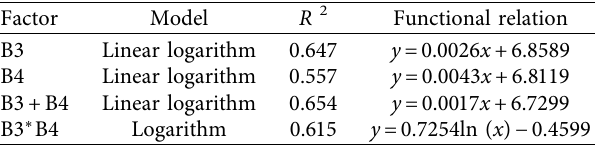
Table 8: Fitting model of pH